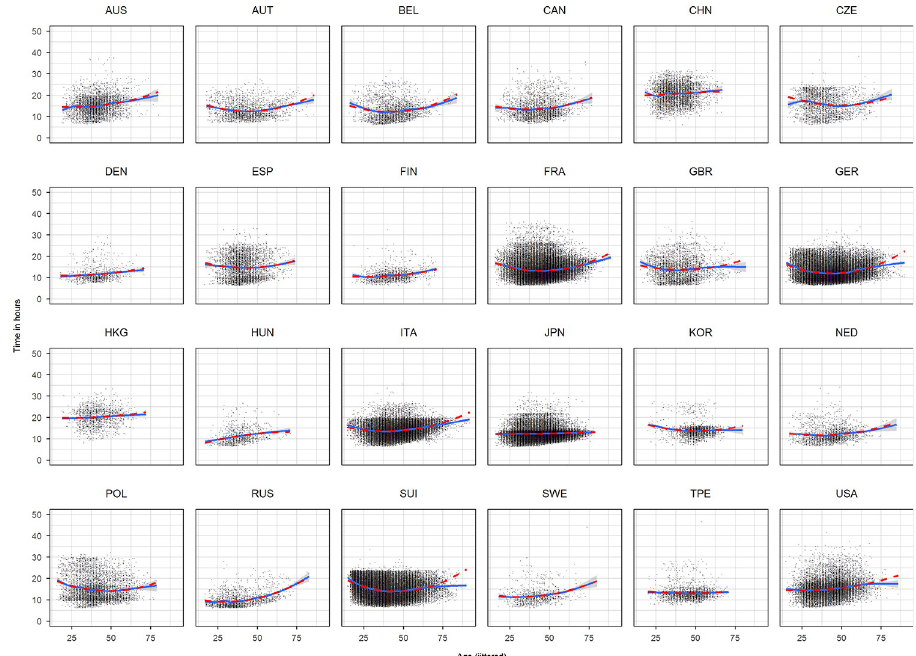
Fig 1. Scatterplots time against age for each nationality based on the complete dataset. Age has been